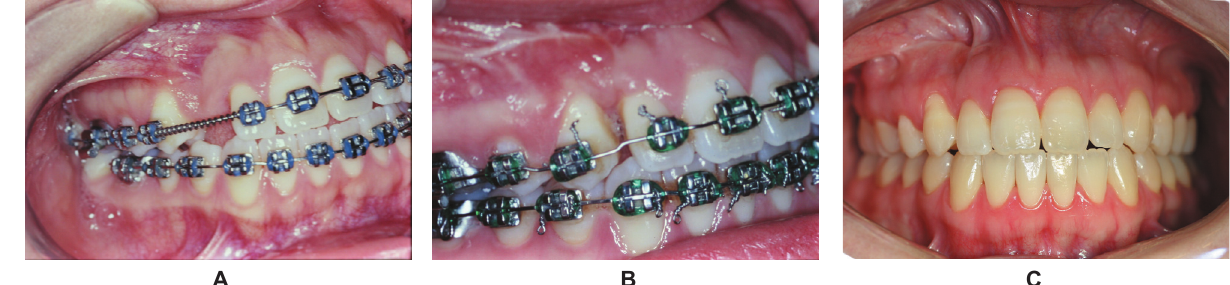
Figure 1- A. Preoperatory aspect. Orthodontic appliance was used to open space for the right maxillary canine traction. B. Oclusion in 30 days postoperative control. Tooth 14 substitutes the lost canine, with closure of the space, in the horizontal immobilization stage, prior to orthodontic alignment. C. Clinical control of 10 years and 10 months postoperatively. Orthodontic appliances were removed for 10 years and 3 months. Patient’s occlusion maintains excellent functional